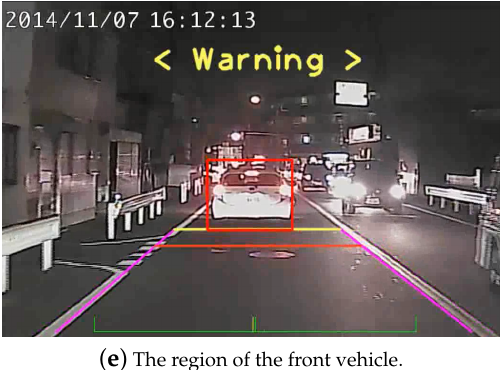
Figure 6. The calculation of the vehicle region using the aspect ratios and intensity histogram in the nighttime